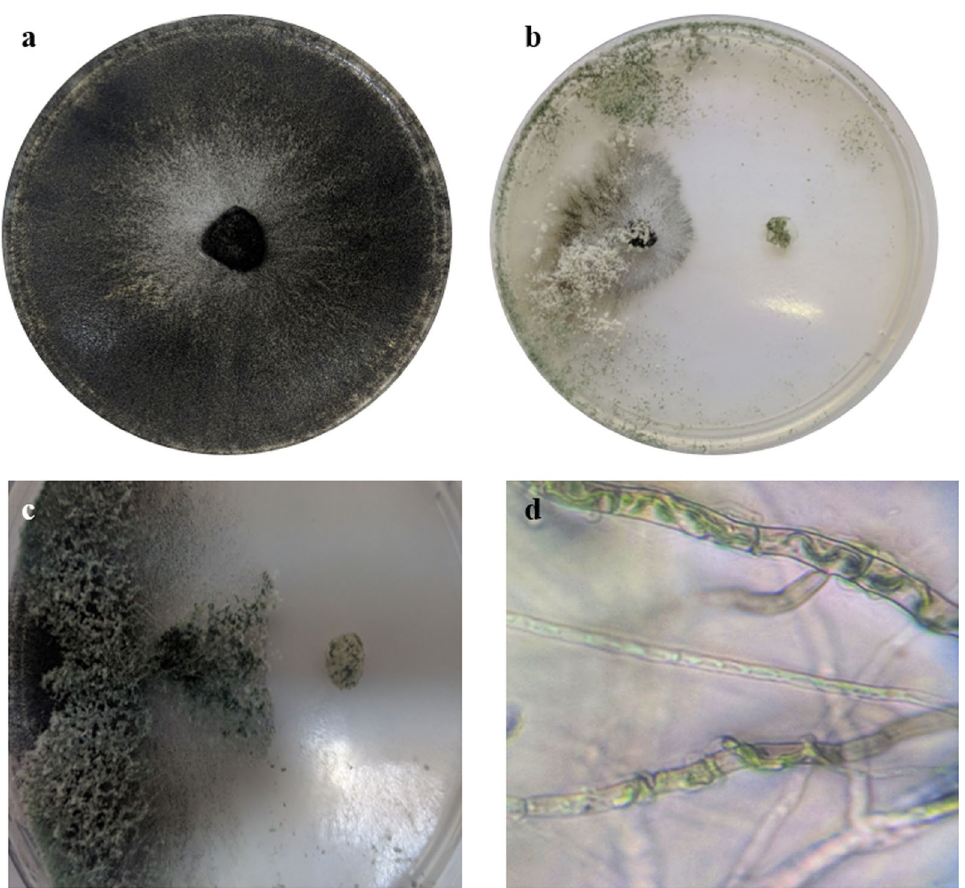
Fig. 3 Direct in vitro confrontation between Trichoderma longibrachiatum (T10) and Macrophomina pseudophaseolina (M1). a Colony of isolate M1 on PDA after 7 days of incubation. b Direct confrontation between T10 and M1. c Invasion of M. pseudophaseolina colony by T. longibrachiatum after